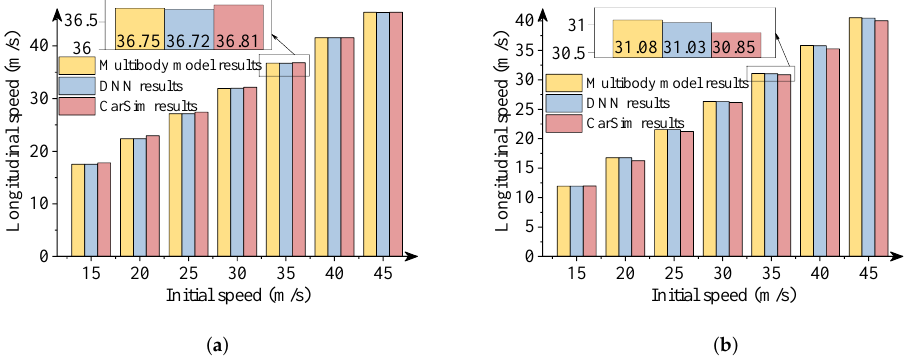
Figure 13. Comparison of longitudinal velocities. ( a ) 300 Nm driving torque; ( b ) − 300 Nm driv- ing